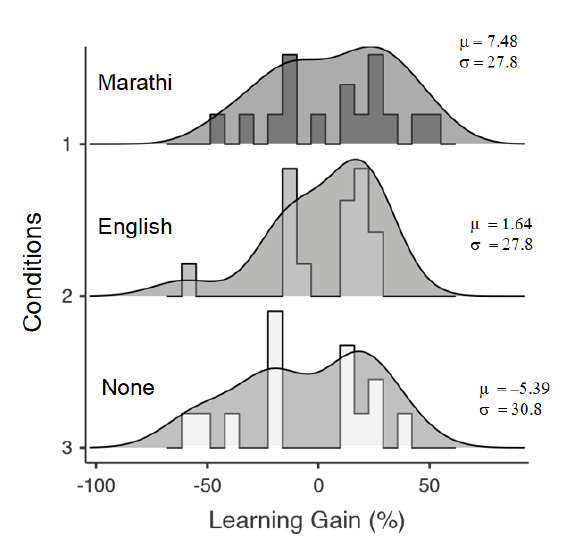
Figure 2. Histograms representing distributions of Hake’s learn- ing gain calculated for each participant under three different con- ditions (Marathi subtitle, English subtitle and No subtitle). The group means and standard deviations are reported.